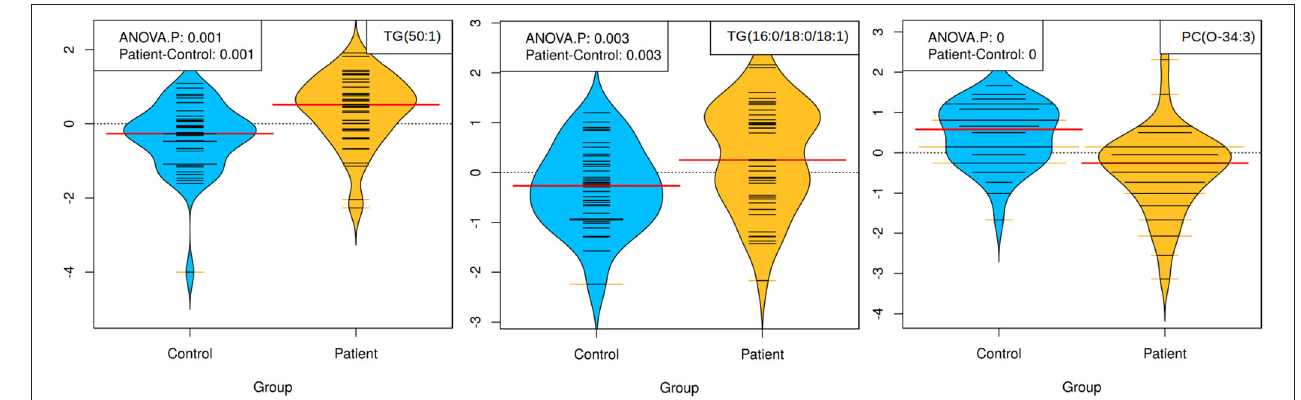
FIGURE 5 | Beanplots showing the levels of TG (50:1), TG (16:0/18:0/18:1) and PC (O-34:3) in plasma collected from patients ( n = 39) and controls ( n = 39). The concentration of lipids followed was calculated based on lipid-class concentration curves. p < 0.05 was considered significant (ANOVA/TukeyHSD).